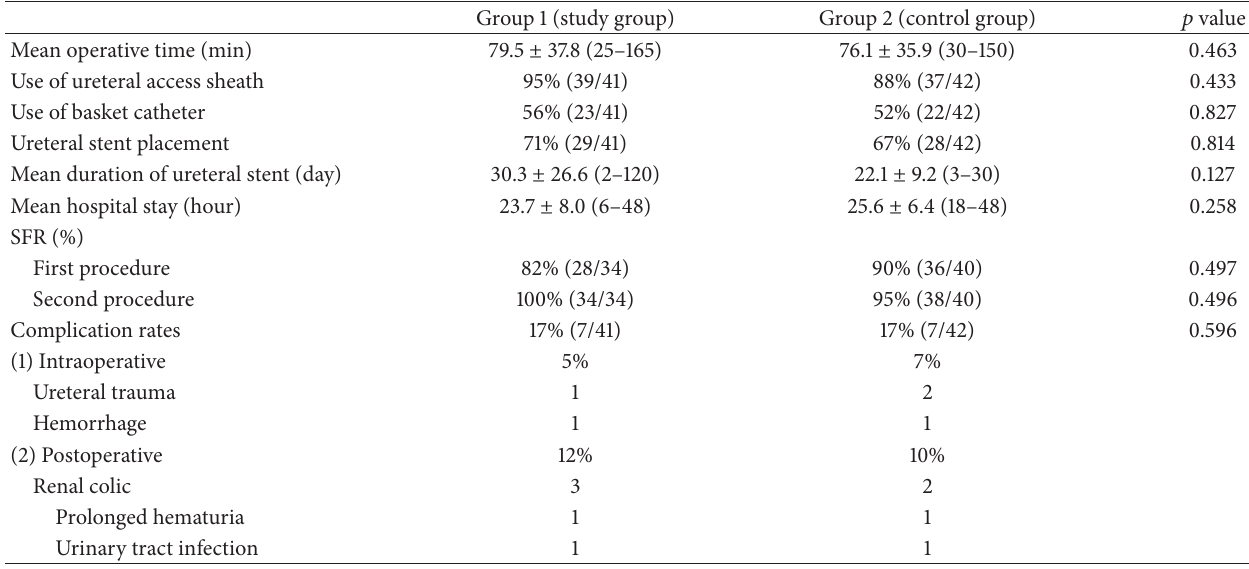
Table 2: Intraoperative and postoperative comparisons between